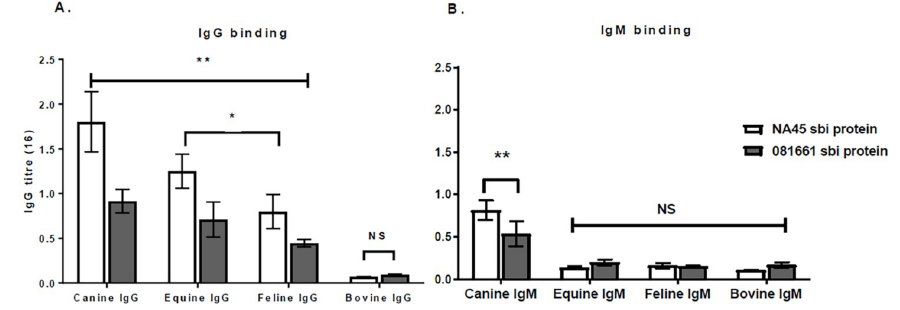
Fig 5. prSbi binding to IgG, IgM and IgG from various animal species. (A) prSbi of NA45 and 081661 binding to IgG was not significantly different p 0.0541. They bound canine, equine, and feline IgG �� (p < 0.0001) and did not significantly bind bovine IgG (NS) in comparison with negative controls. The binding of prSbi proteins with feline IgG and equine IgG was lower than canine IgG � (p < 0.05). (B) Binding of prSbi to IgM. prSbi from NA45 and 081661 bound significantly different amounts of IgM p = 0.045. They had significant reactivity with canine IgM �� p < 0.0001 and not with bovine, equine, and feline IgM